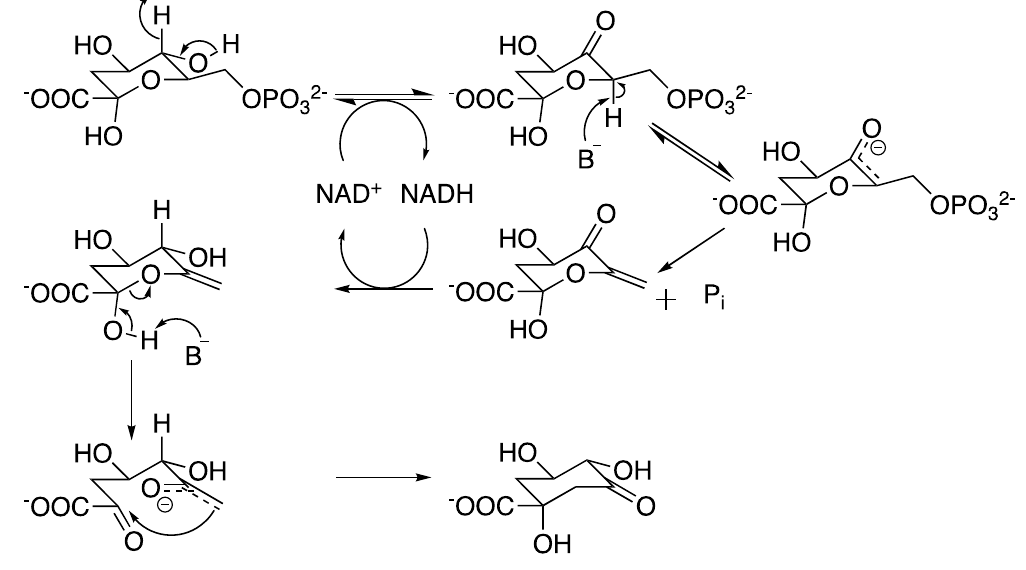
Figure 6. Multi-step reaction catalyzed by Mt DHQS.